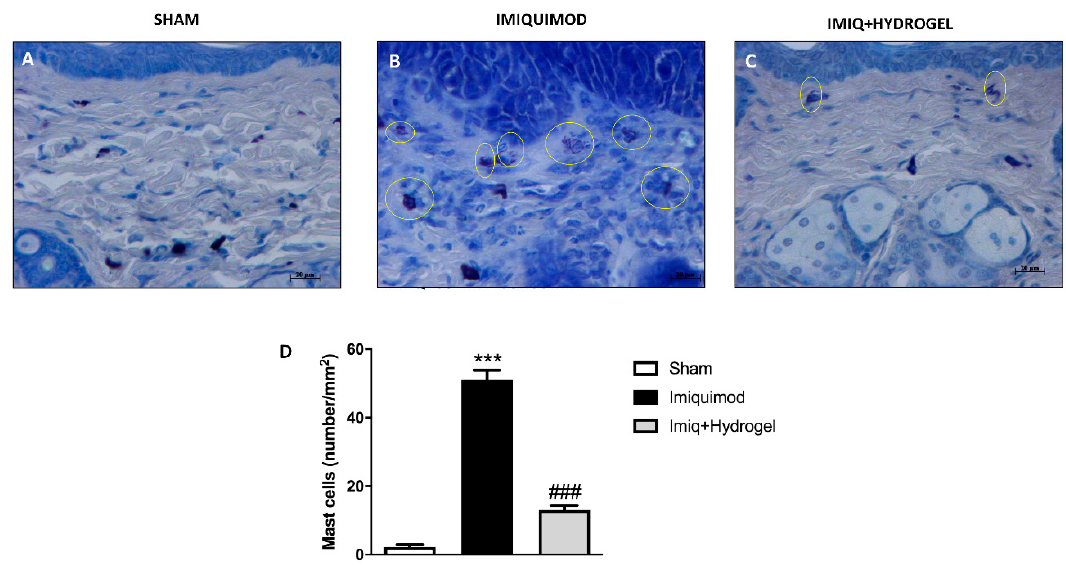
Figure 5. E ff ect of Hydrogel treatment on Mast cell quantification. Mast cell counts by toluidine blue staining. An increased number of mast cells were identified in the epidermis of IMQ-treated mice ( B magnification 40 × , D ), compared to the control group ( A magnification 40 × , D ). Hydrogel administration reduced the presence of mast cell infiltrate ( C magnification 40 × , D ). Data are representative of at least three independent experiments; One-Way ANOVA test. *** p < 0.001 vs. sham; ### p < 0.001 vs. IMQ.